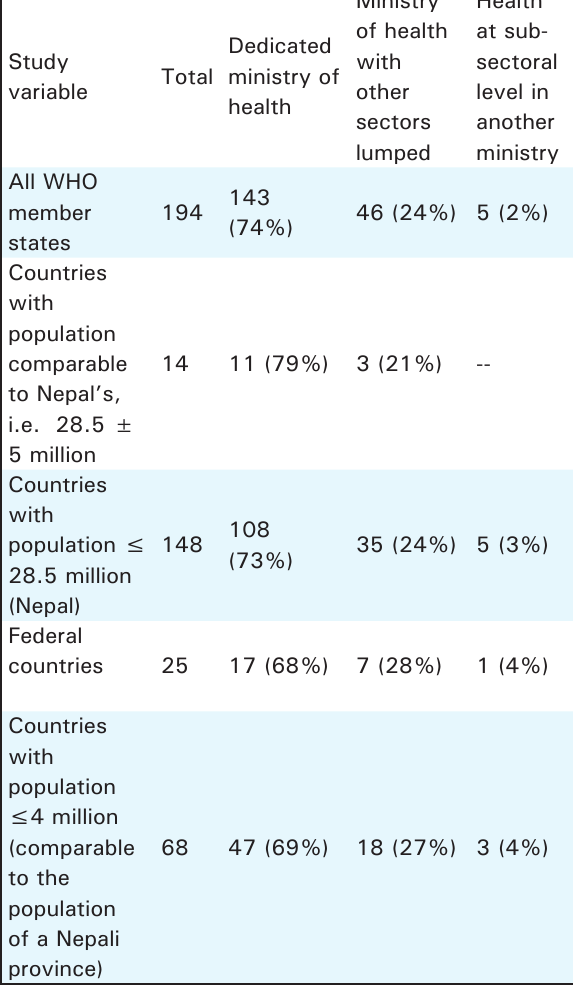
Table 1. Summary of findings from countries’